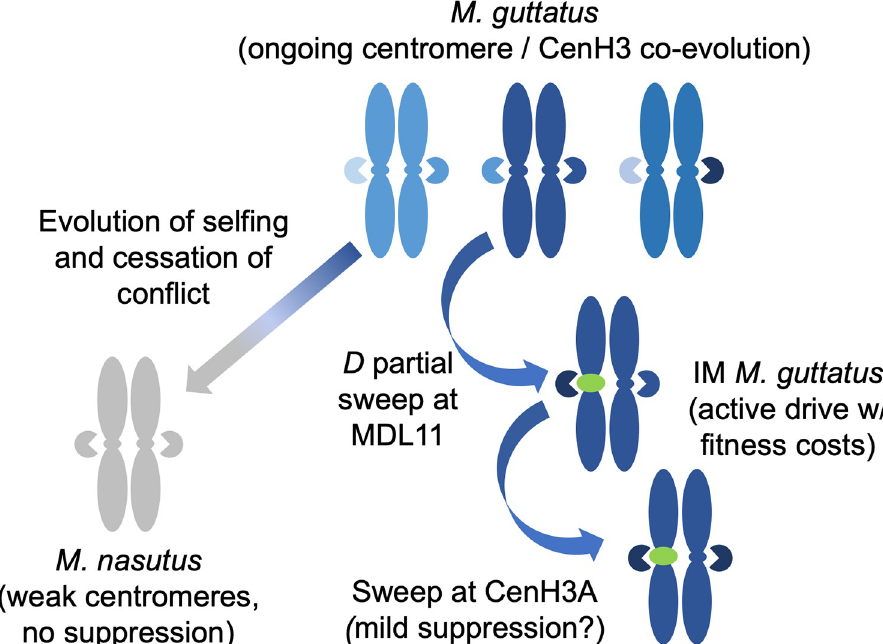
Fig 5. Hypothesized processes underlying differences between heterospecific (strong) and conspecific (weak) centromeric drive in yellow monkeyflowers, as well as population genetic signatures of recent D -CenH3A co- evolution in Iron Mountain (IM) Mimulus guttatus . Shades of blue represent M . guttatus standing diversity at centromeres (ovals on chromosomes), CenH3A (pie shapes), and other loci, green represents the driving D centromere (potentially facilitated by linked genes), and grey represents the relatively drive-permissive centromere and genetic background of selfer M . nasutus .